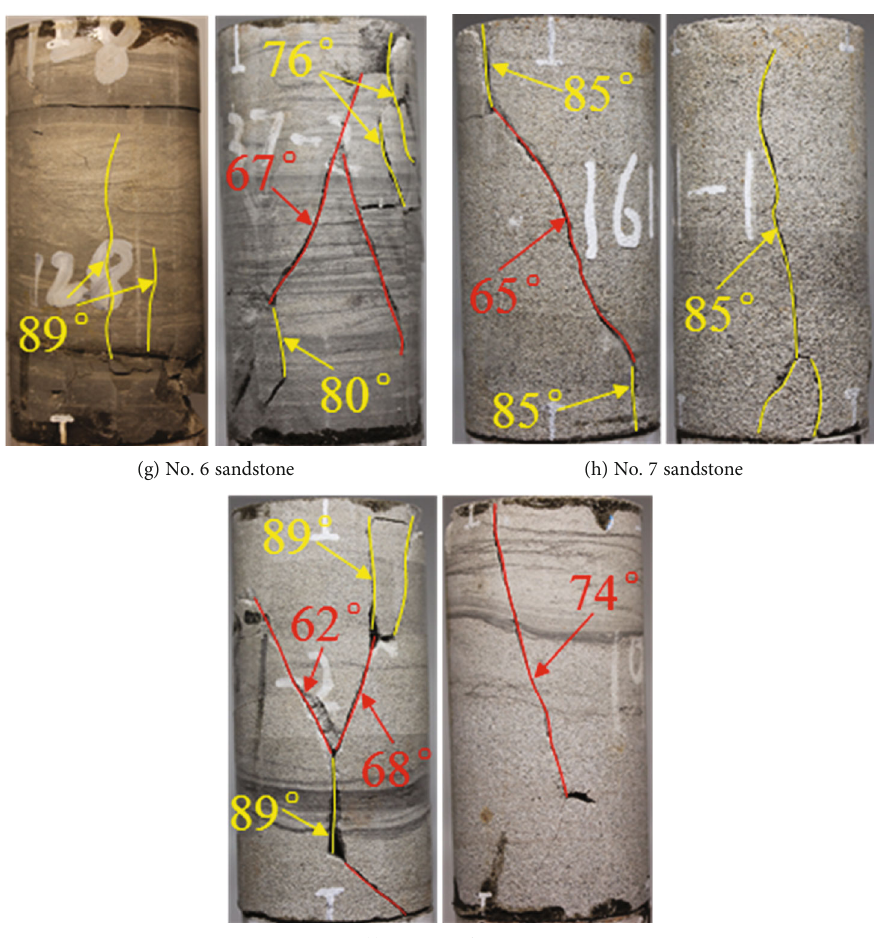
Figure 11: Failure patterns of sandstone of di ff erent rock